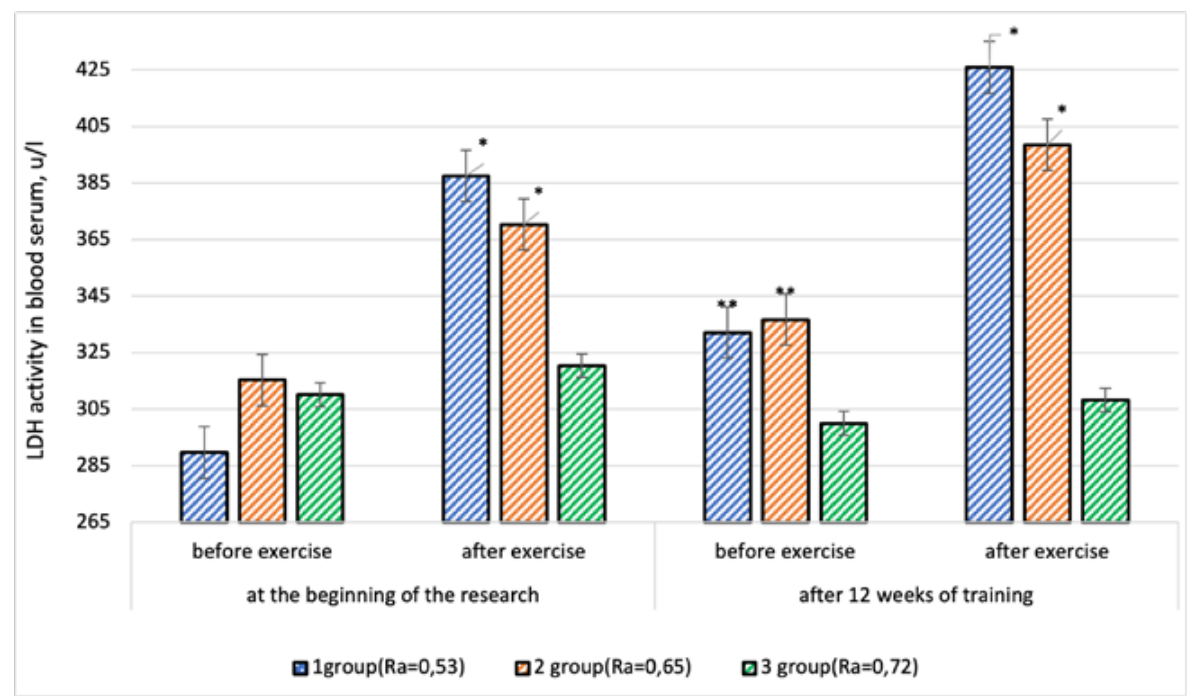
Figure 2. Changes in LDH activity in the blood serum of study participants during 12 weeks of training in the conditions of different intensity power load regimes, n=75 Note: * – p<0.05, compared to the indicators before the load; ** – p<0.05, compared to the indicators before the study